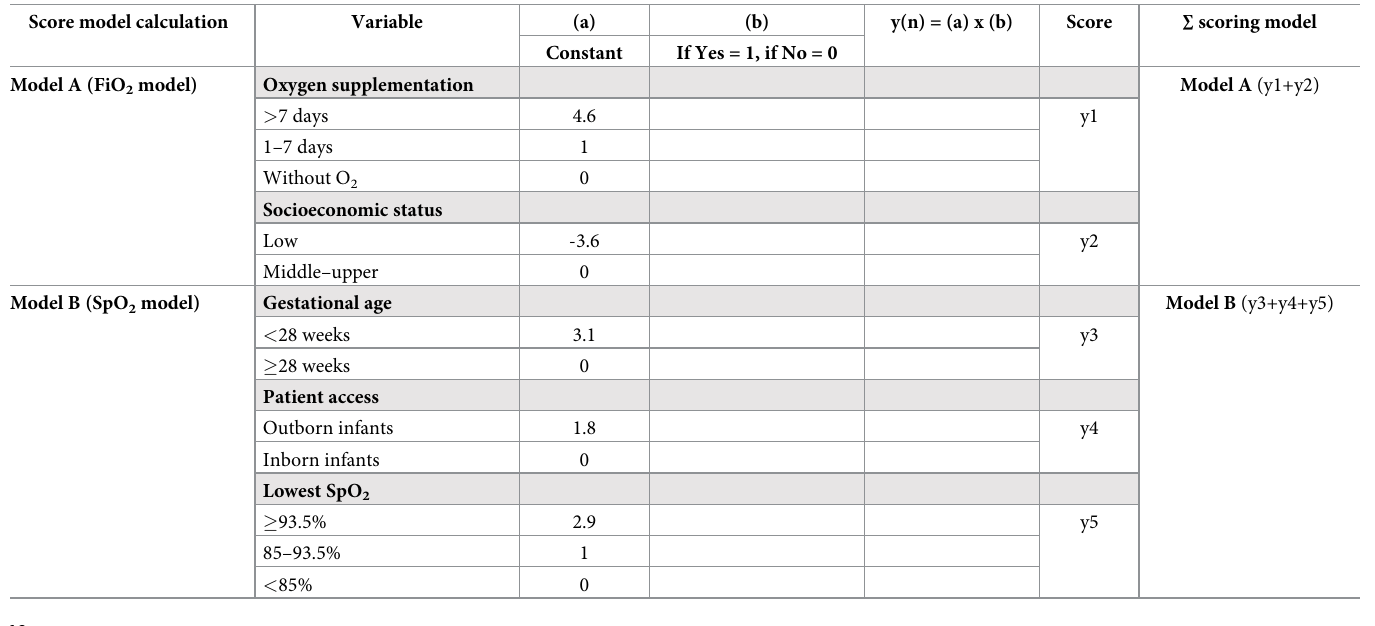
Table 3. The ROP risk scoring